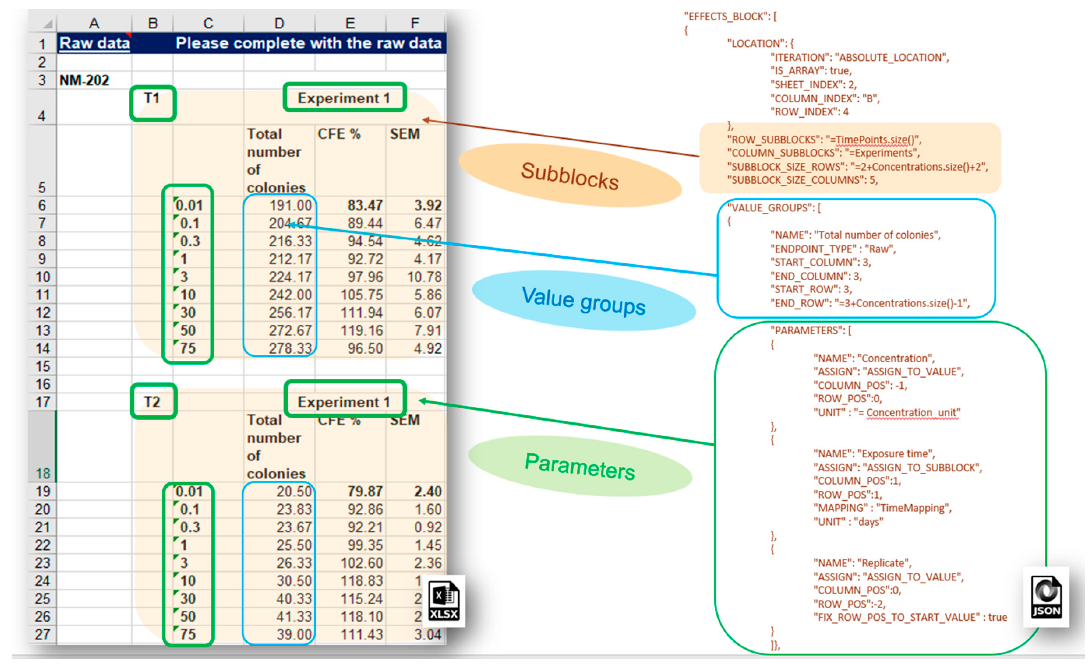
Figure 9. JSON configuration on an EFFECT_BLOCK; definition of sub-blocks, value groups and parameters of the value groups, which are the experimental